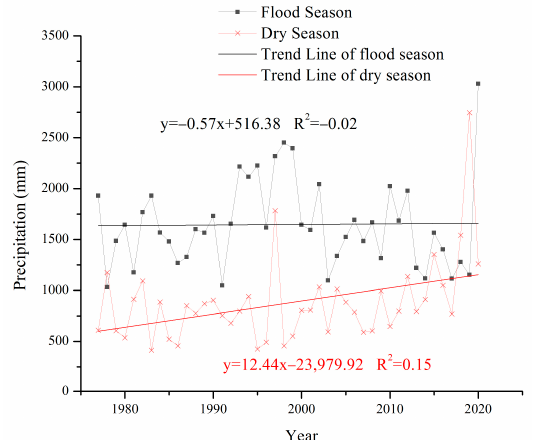
Figure 9. Total of the seasonal precipitation in Poyang Lake during 1977–2020.